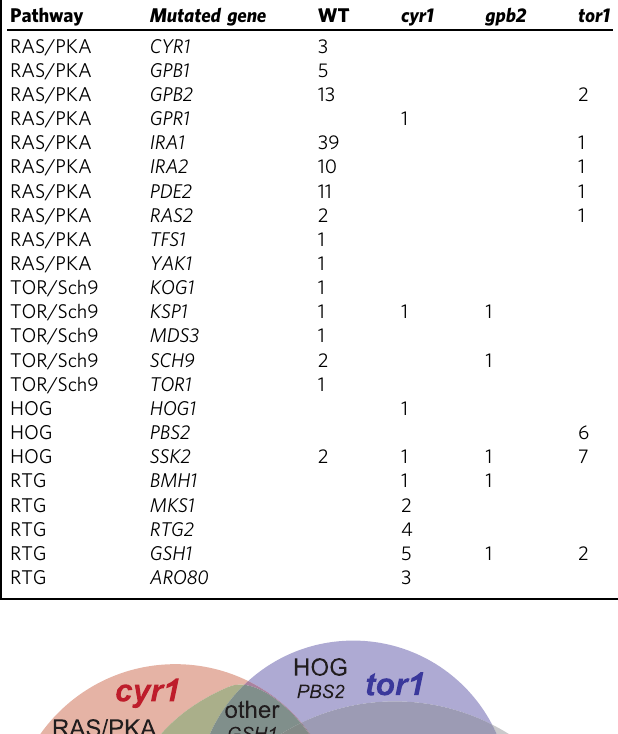
Table 3 Genetic basis of adaptation per founder.